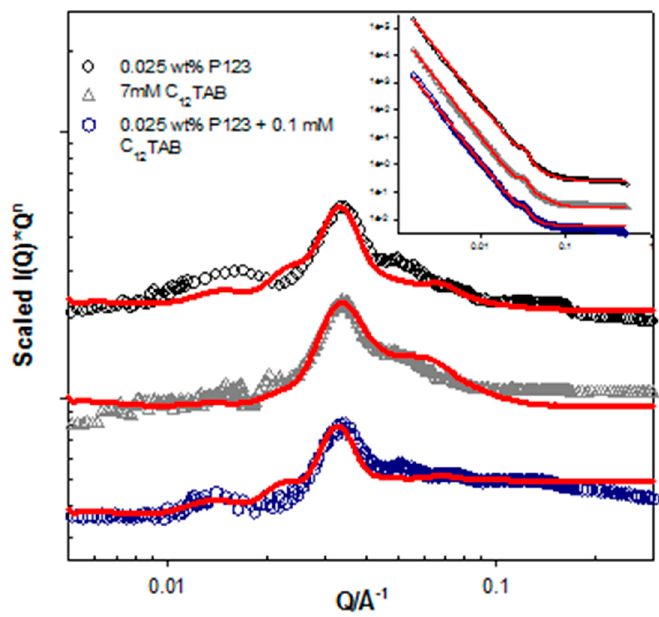
Figure 1. Small-angle scattering recast into an I ( Q )* Q n vs. Q format arising from foam stabilised by Pluronic P123, C 12 TAB and their mixture, recorded on the D11 diffractometer. Data have been offset for clarity. The inset figure presents the raw data. Solid lines are fits to the multilayer model. Both the main figure and the inset are presented in a double logarithmic representation. All samples were prepared in D 2 O.